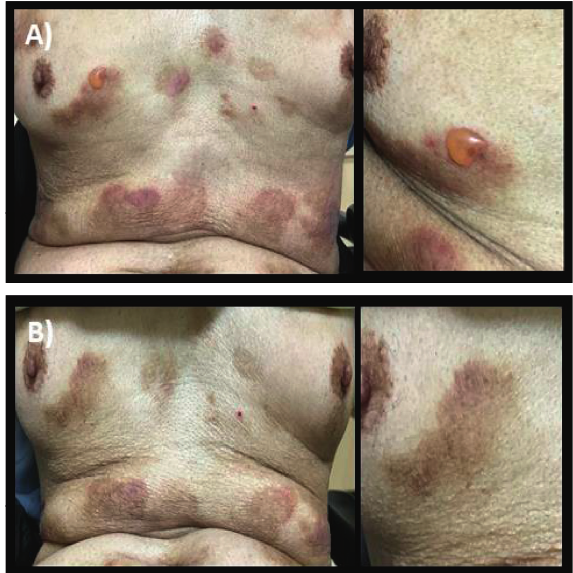
Figure 3: (a) Disseminated bullous pemphigoid and a close up image of bullae on the chest wall in Case no.4 before sitagliptin withdrawal and (b) improvements of skin lesions in this patient after 2 weeks of sitagliptin